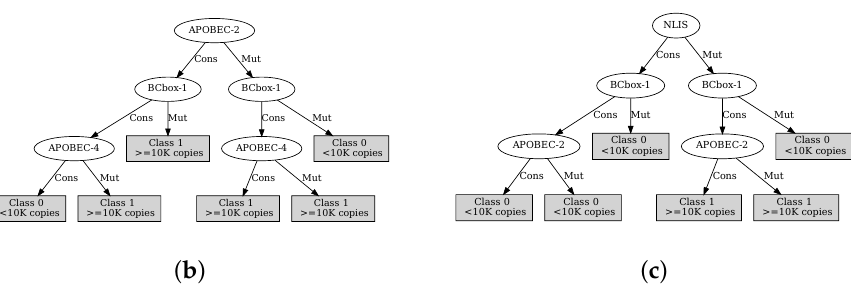
Figure 6. ID3 inducted trees using the suggested most relevant variables per output as defined by the MAREV-2 approach. ( a ) The tree for CD4Ini; ( b ) The tree for CD4Hist; ( c ) The tree for VLIni; ( d ) The tree for VLHist.